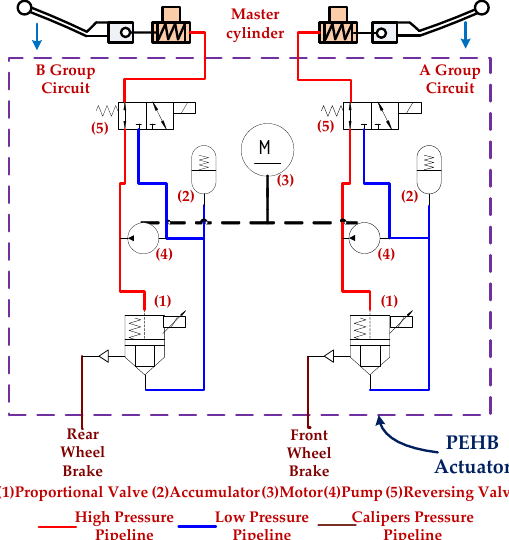
Figure 3. The novel control circuit for a proportional electro-hydraulic brake (PEHB) actuator of a